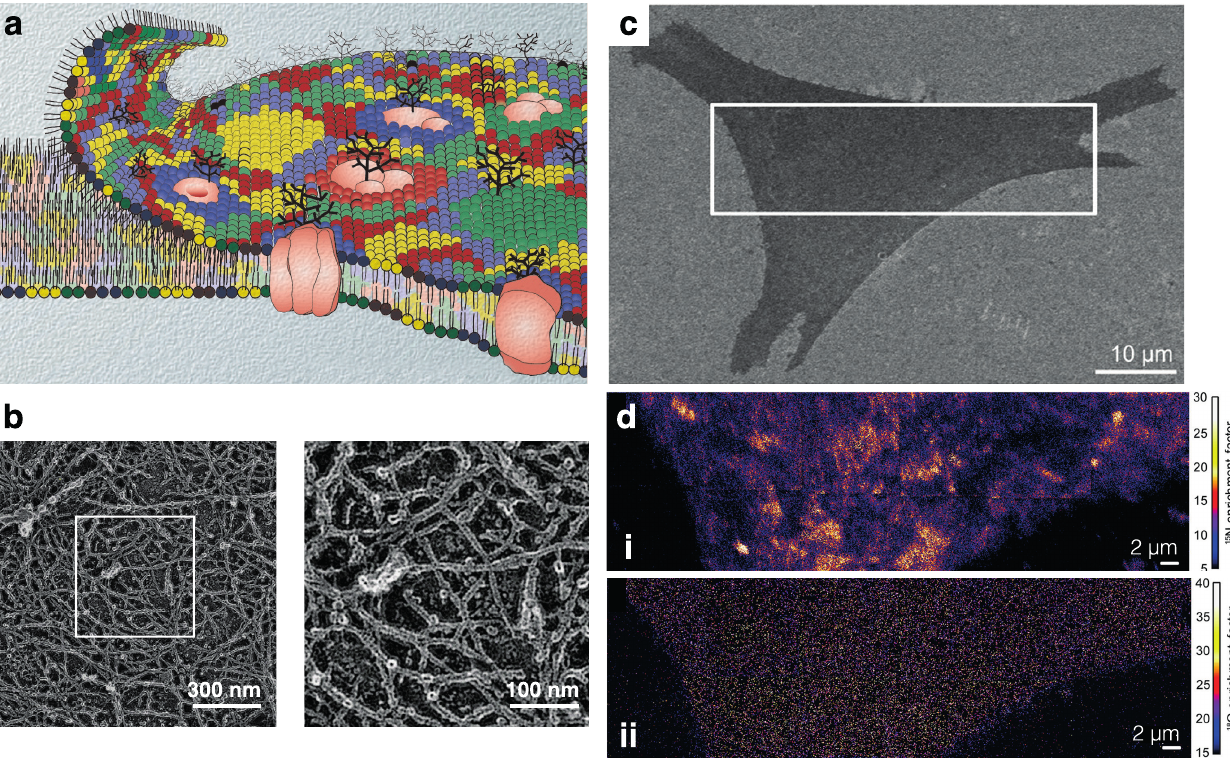
Figure 1. A chemical view of the cell membrane. ( a ) Image of membrane bilayer exhibits a patchwork mosaic of the distribution of lipids in the cell membrane and captures the lateral heterogeneity of the organization of membrane components in live cells. ( b ) This bilayer is anchored to the cortical actin meshwork as visualized by rapid-freeze deep-etch tomographic renderings of the cortical surface closest to the membrane. ( c ) Scanning electron microscopy image of a fibroblast cell. ( d, i ) The distribution of metabolically incorporated 15N-sphingolipids in the plasma membrane region indicated above represented as the detected sphingolipid-specific 15N-enrichment with NanoSIMS. Orange and yellow regions represent plasma membrane domains that are enriched with 15N-sphingolipids. ( d, ii ) The distribution of 18O-enrichment showing that the metabolically incorporated 18O-cholesterol is distributed relatively uniformly in the plasma membrane. Images ( a ), ( b ), and ( c ) and ( d ) are reproduced with permission from 6,19, and 35,